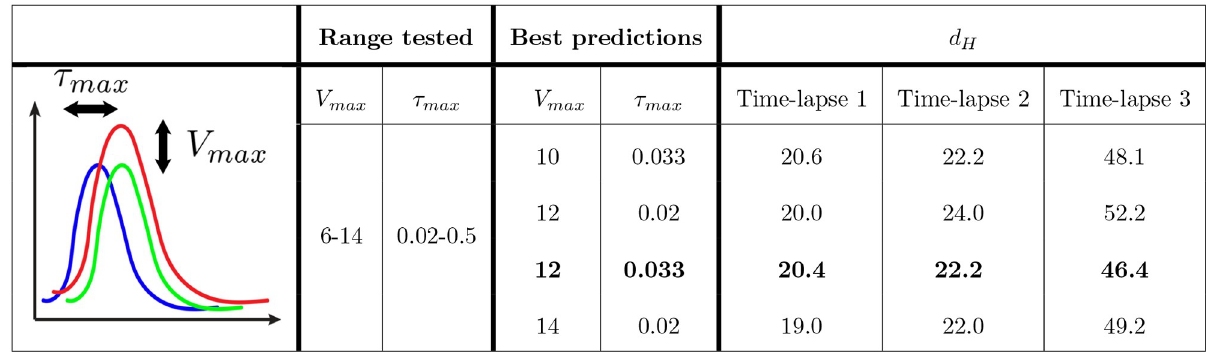
Fig 7. Visual representation and four lowest scores for variations in V distance are shown for three different experiments. The variable which provides the smallest d H for all cases was selected (bold).